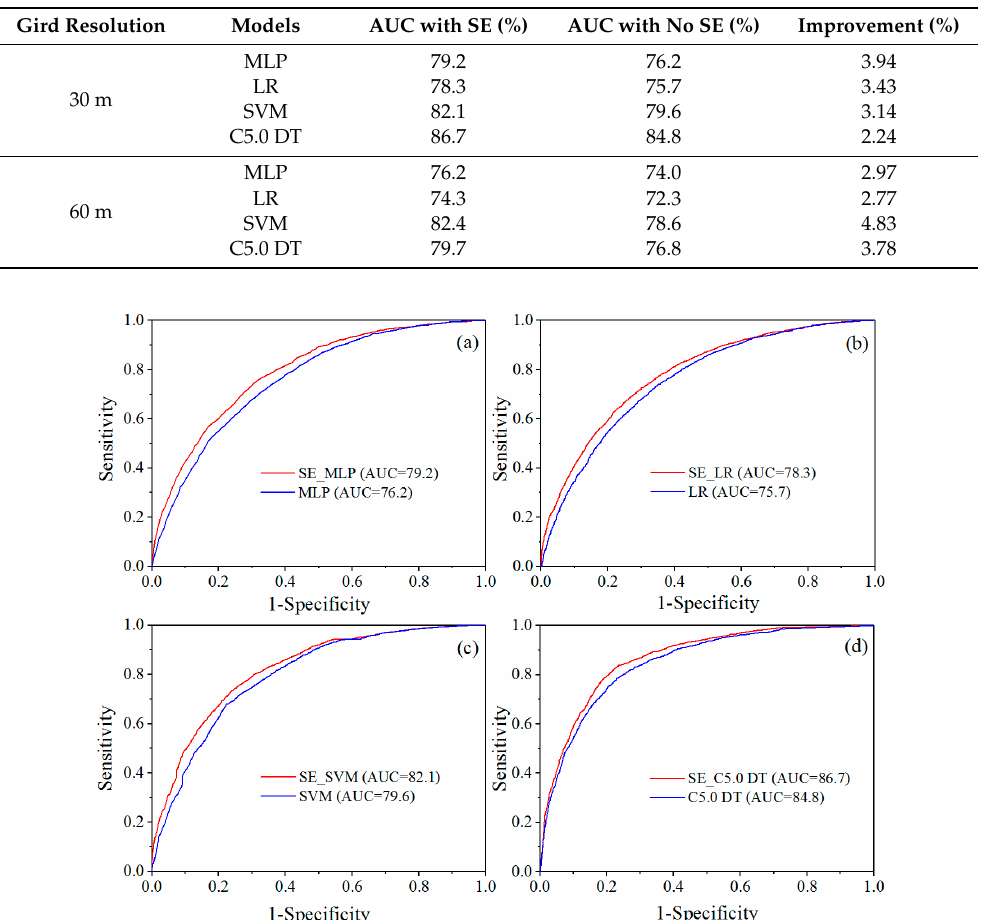
Figure 9. AUC value of each model with grid resolutions of 30 m: AUC values of SE_MLP and MLP models ( a ); AUC values of SE_LR and LR models ( b ); AUC values of SE_SVM and SVM models ( c ); AUC values of SE_C5.0 DT and C5.0 DT models ( d